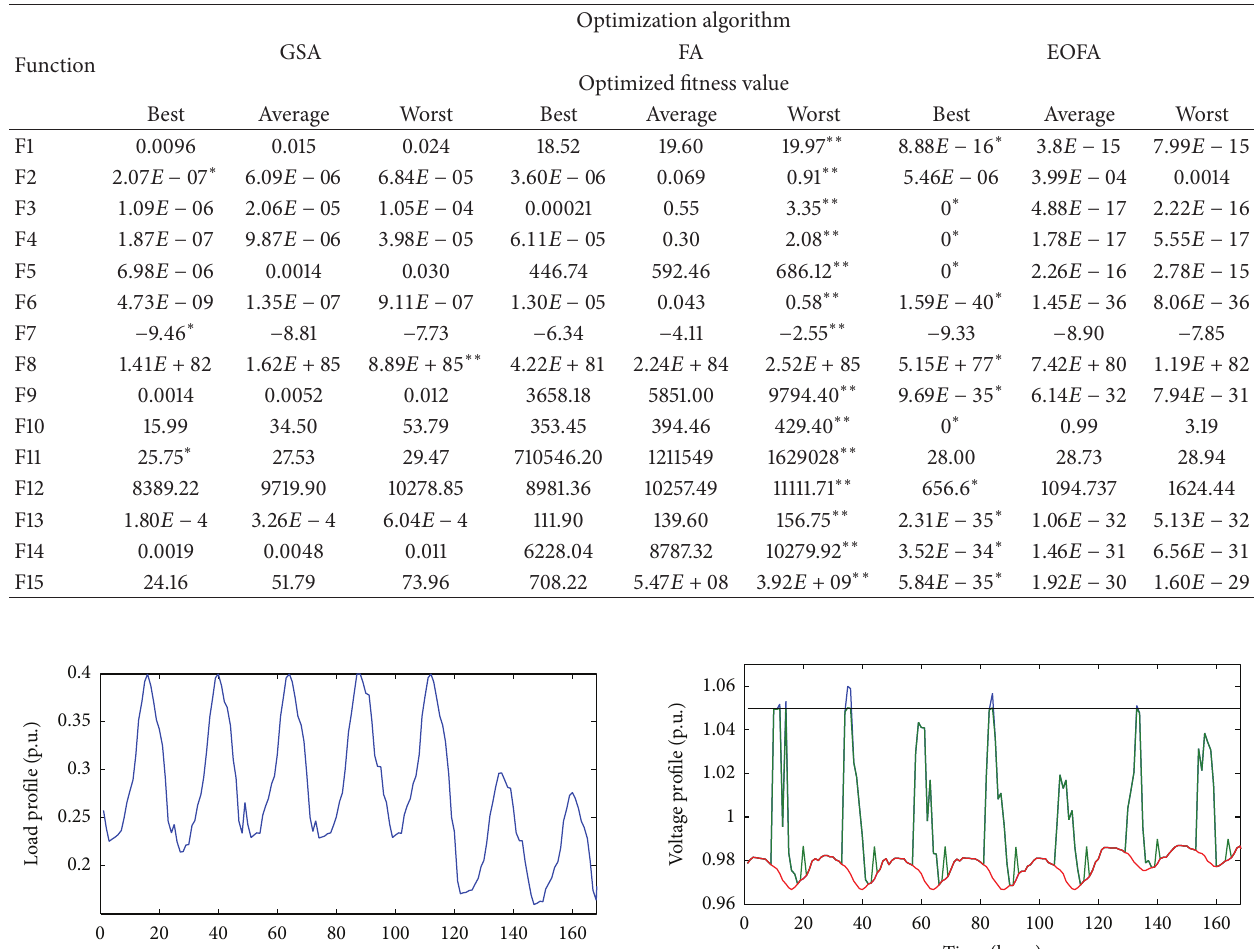
Table 2: Comparison of performances for GSA, FA, and EOFA.